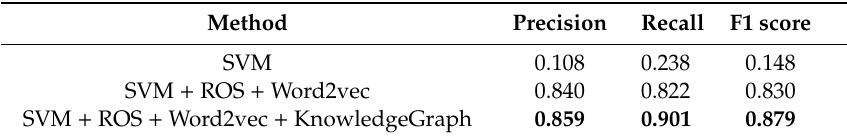
Table 5. Mutianyu_Great_Wall experiment results.